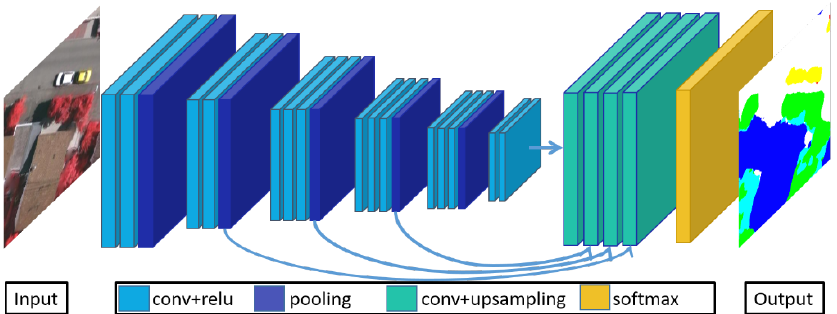
Figure 1. Multi-resolution model for the analysis of the contribution of individual layers to each class. conv: convolution layer, relu: Rectifying Linear Unit